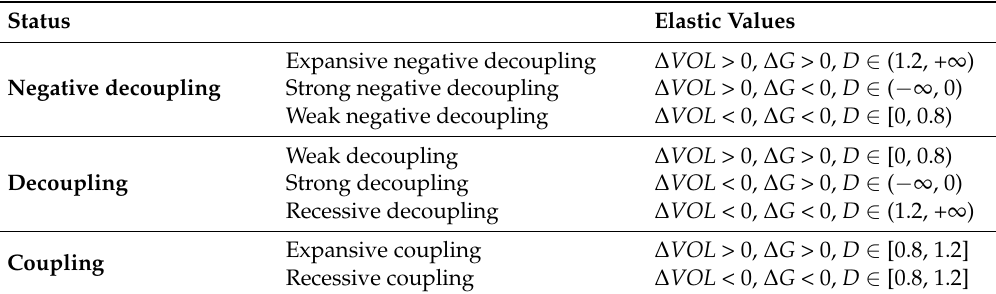
Table 1. Criteria of decoupling